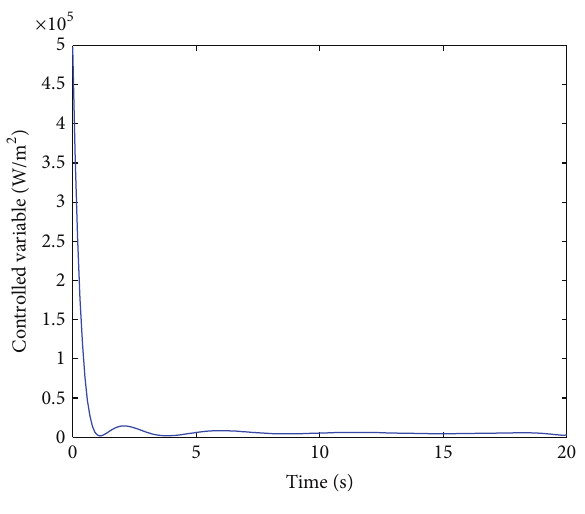
Figure 12: Controlled